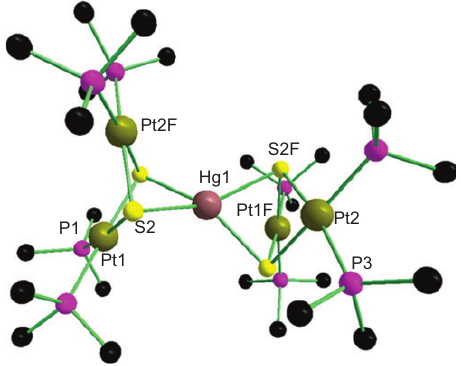
Figure 2 Molecular Structure of [ { (acac)(C^P)PtHgBr( μ -Br) } (Ara et al.,